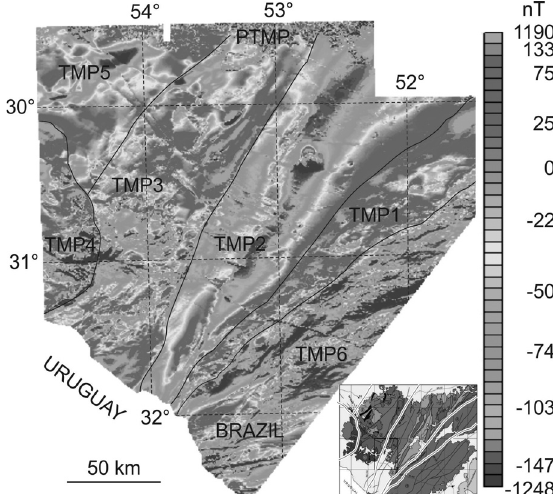
Figure 11 - Differential reduction to pole (DRTP) of the aeromagnetic anomalies over the Sul-Riograndense Shield; intensity of signal is dependant on crust + shallow upper mantle magnetism. Total magnetic provinces indicated (e.g., TMP6). Contact between provinces described in Figure 10 are pasted on this fi gure for comparison. For interpretation of the references to color in this fi gure legend, the reader is referred to the web version of this article.